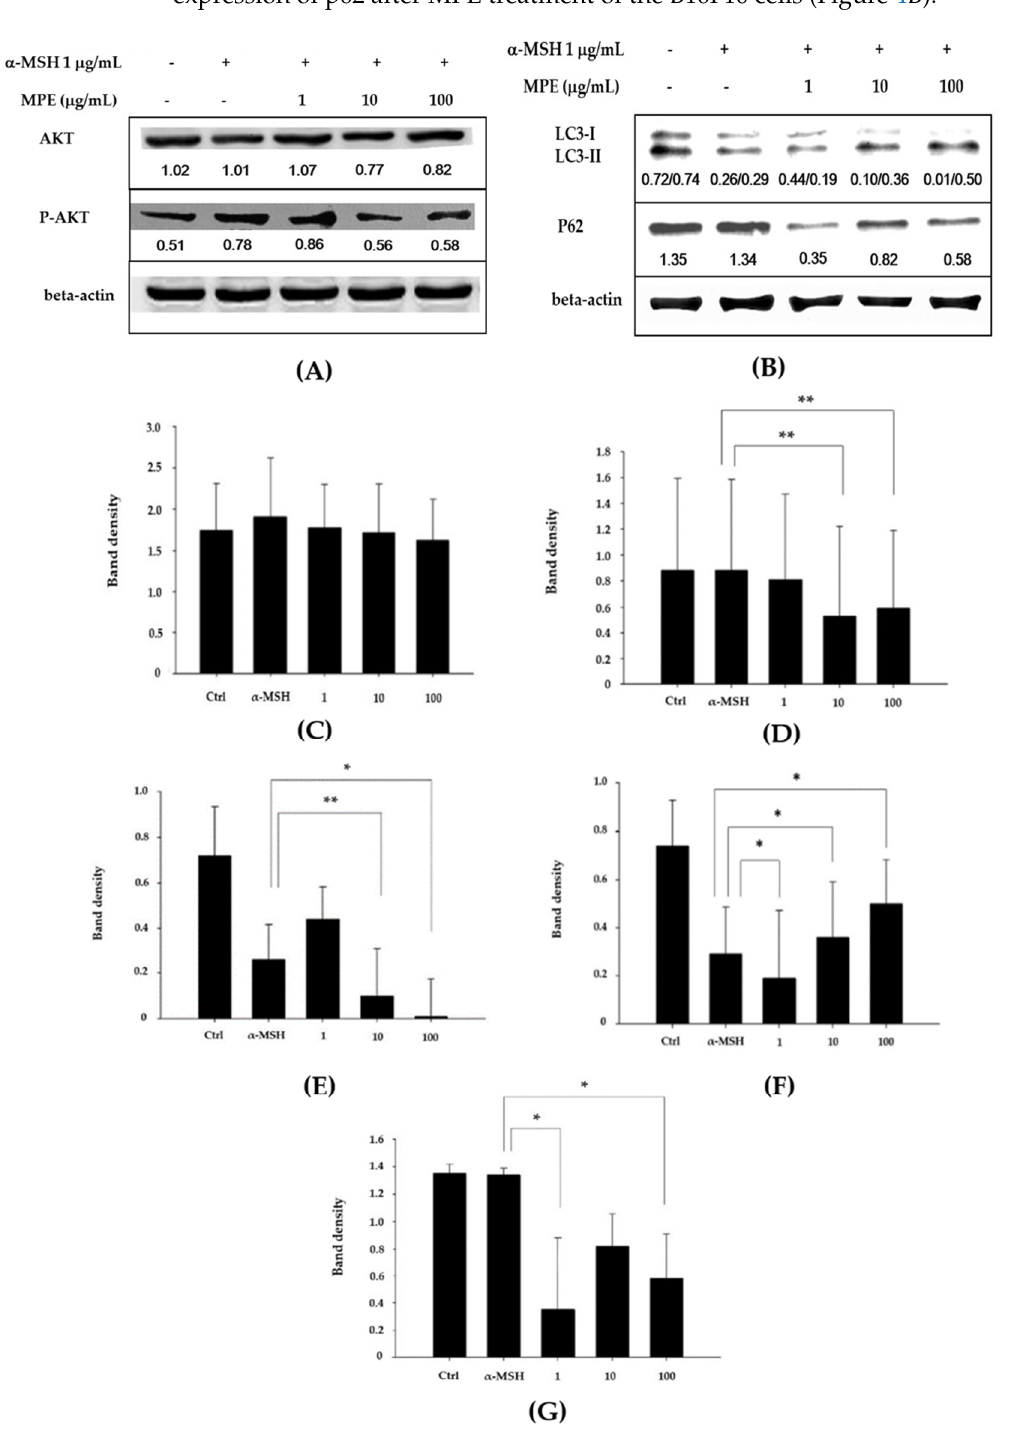
Figure 4. Effect of MPE on melanogenesis inhibition through the AKT signaling and autophagy pathways. ( A ) The expression levels of p-AKT and AKT proteins in B16F10 cells after treatment with MPE at the concentration of 1, 10, or 100 µ g/mL for 24 h. ( B ) The expression levels of P62 and LC3 proteins in B16F10 cells after treatment with MPE for 24 h. ( C ) AKT protein expression (mean ± SD, n = 3). ( D ) p-AKT protein expression (mean ± SD, n = 3) ( E ) LC3-I protein expression (mean ± SD, n = 3) ( F ) LC3-II protein expression (mean ± SD, n = 3) ( G ) p62 protein expression (mean ± SD, n = 3); * p < 0.01; ** p <